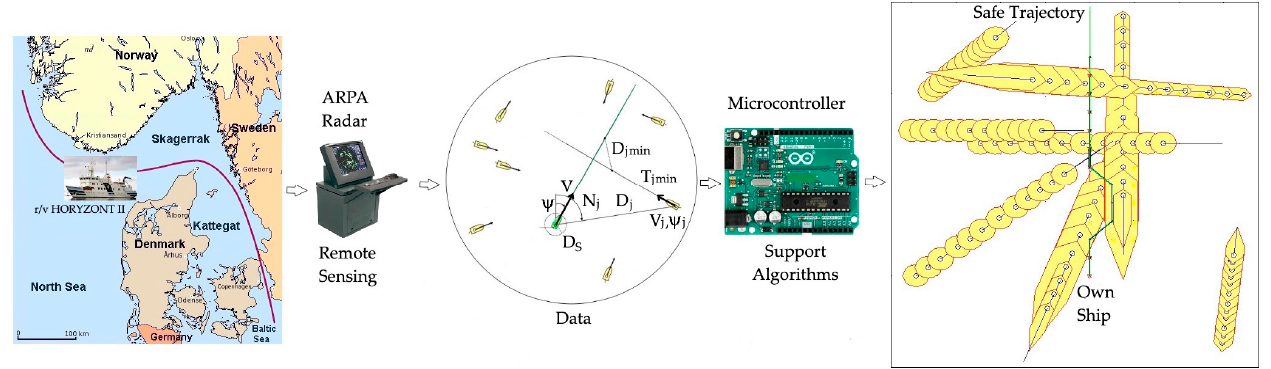
Figure 1. Graphical presentation of the functioning of the navigator support system tested on a research and training vessel r/v HORYZONT II in a real marine environment in the Skagerrak– Kattegat Straits: V, ψ is the speed and course of one’s own ship; V j , ψ j is the encountered j ship speed and course; D j , N j is the distance and bearing to j the encountered ship; D is the safe passing distance for ships in real conditions of visibility at sea; D jmin , T jmin is the distance and time to the closest approach of the ships.